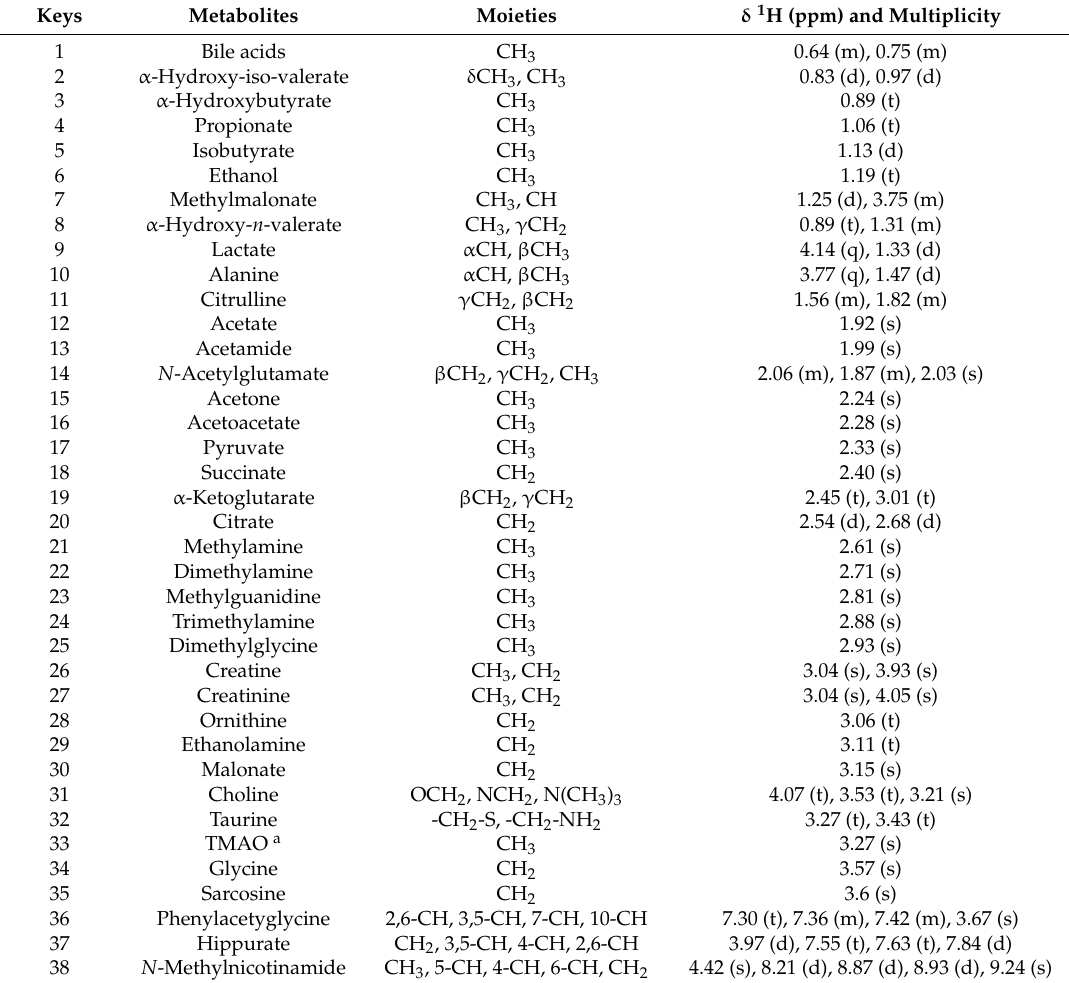
Figure 1. Typical one-dimensional 1 H-NMR spectra obtained from representative rat urine samples of the control and arginine groups. The region of δ 6.2 to δ 9.5 was magnified four times compared with the corresponding region of δ 0.7 to δ 6.2 for clarity. A total of 51 metabolites were assigned. The chemical shifts and peak multiplicities of these metabolites are shown in Table 2. Table 2. 1 H-NMR data of metabolites in rat urine.